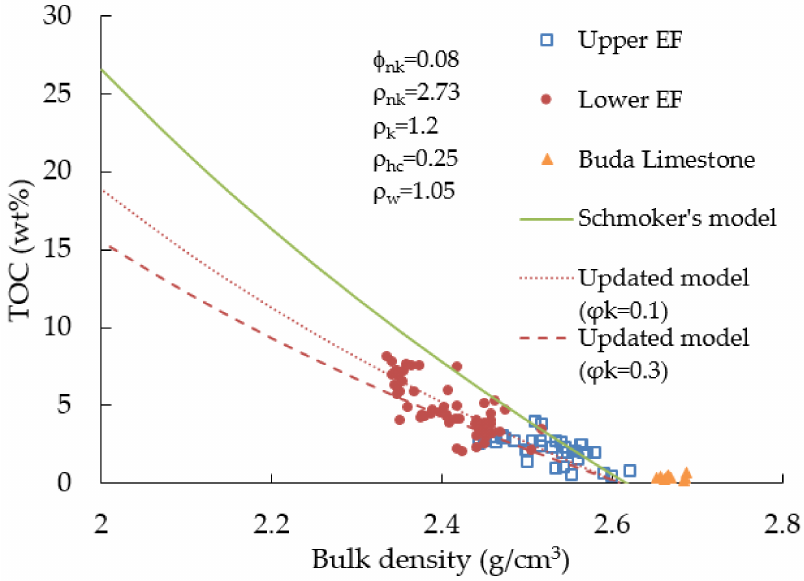
Figure 7. Comparison between the updated model and Schmoker’s